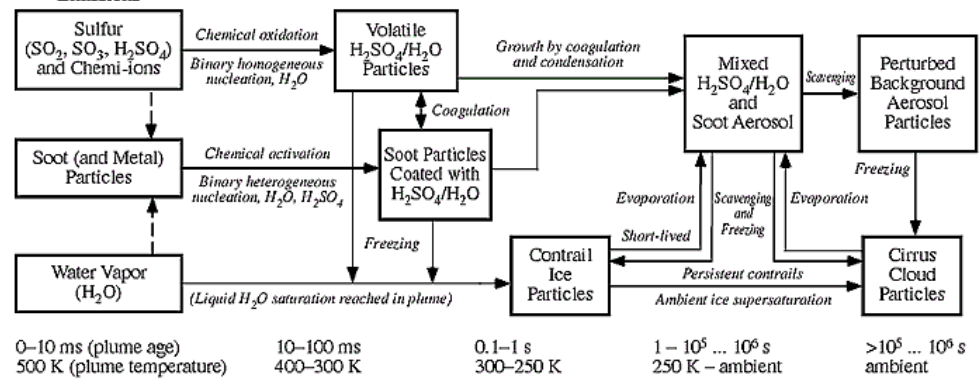
Figure 15. The microphysical formation of aerosol and contrail particles in an aircraft plume. Dis- played as a function of plume age and temperature. Reprinted with permission from IPCC special report (1999) [14]. Copyright 2022, Cambridge University